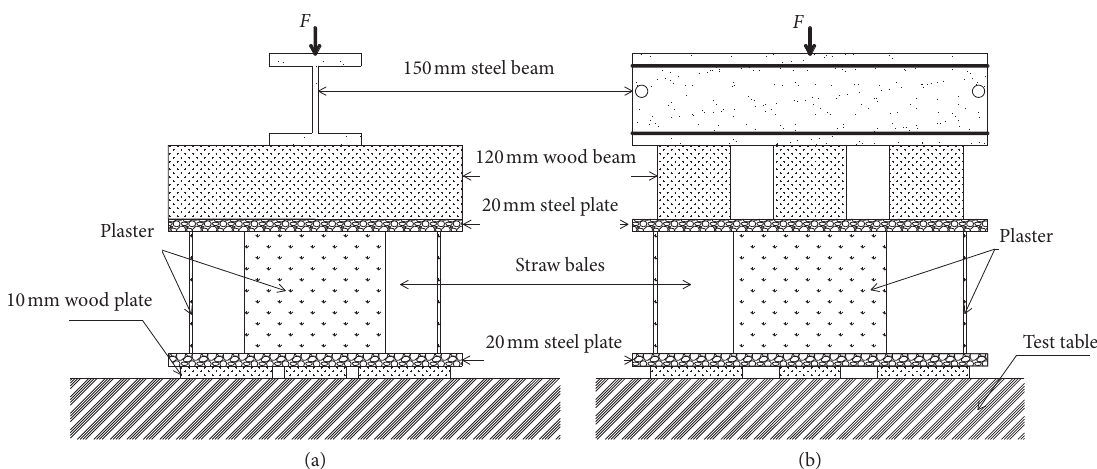
Figure 6: The experimental setup of plastered straw bales. (a) Front elevation. (b) Side